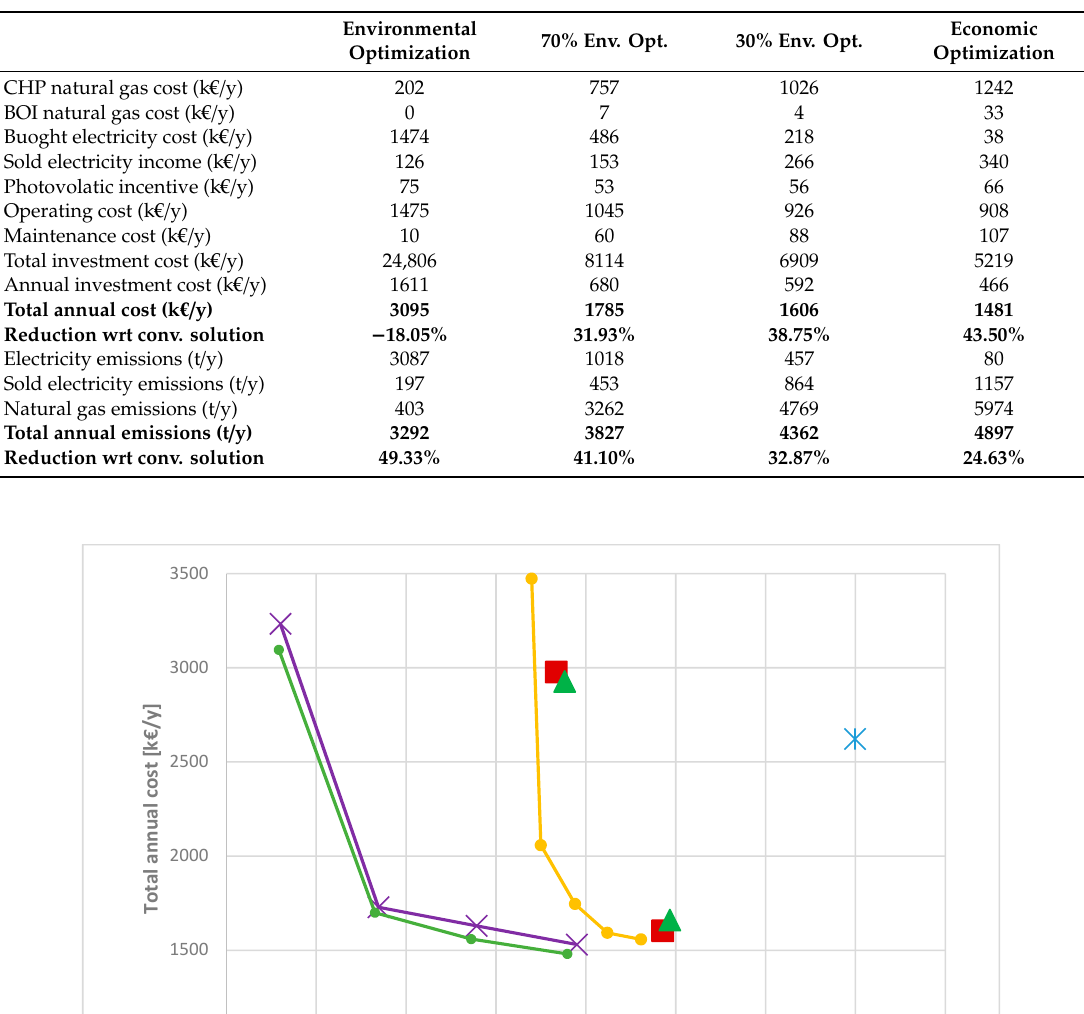
Table 16. Total economic and environmental results of the optimizations—complete distributed generation solution.